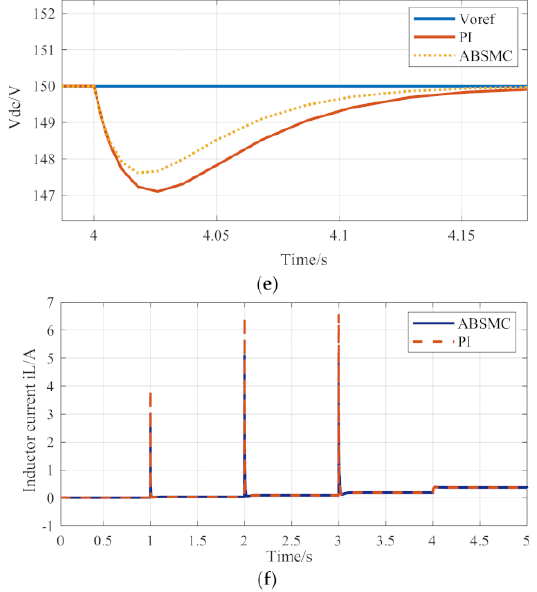
Figure 6. Voltage and current double closed-loop cascade control simulation. ( a ) Converter output voltage response. ( b ) Phase I response. ( c ) Phase II response. ( d ) Phase III response. ( e ) Phase IV response. ( f ) Converter inductor current response.